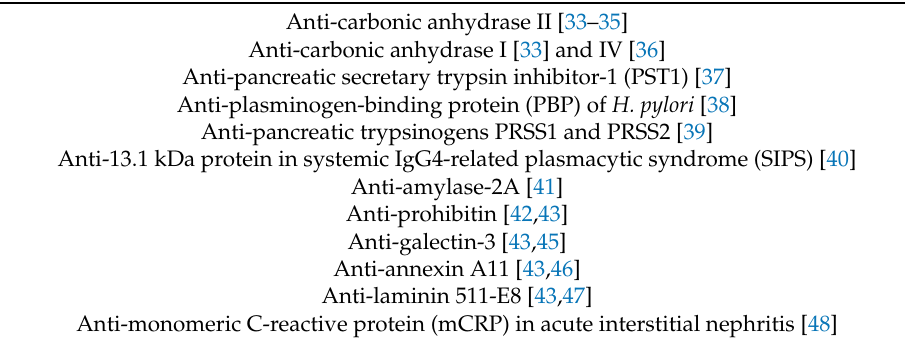
Table 3. The presence of autoantibodies in patients with IgG4-related